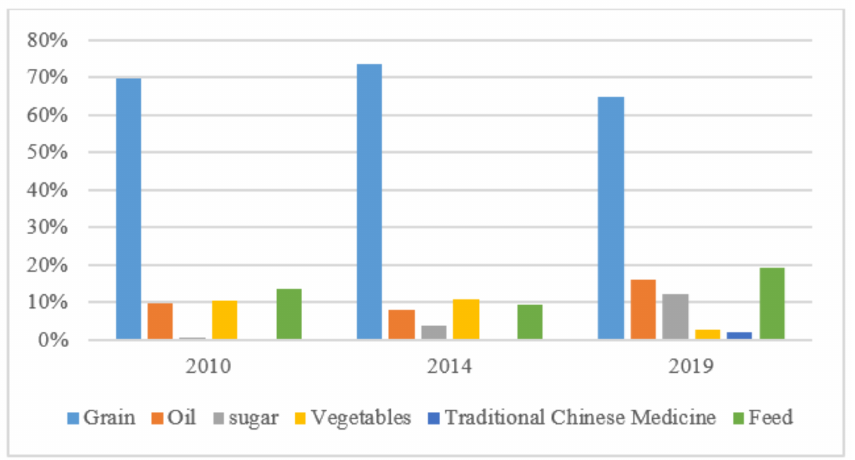
Figure 10. The changes in planting structure in Taibus from 2010 to